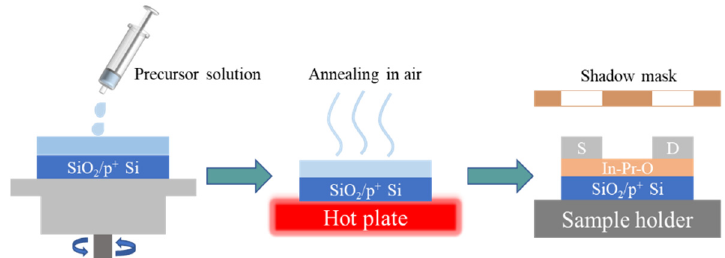
Figure 1. Schematic showing the fabricated In-Pr-O